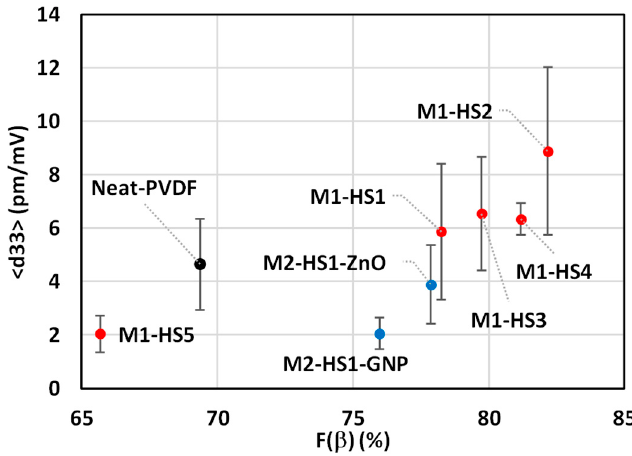
Figure 10. Averaged d 33 as a function of F ( β ) of all produced samples, with standard deviation.